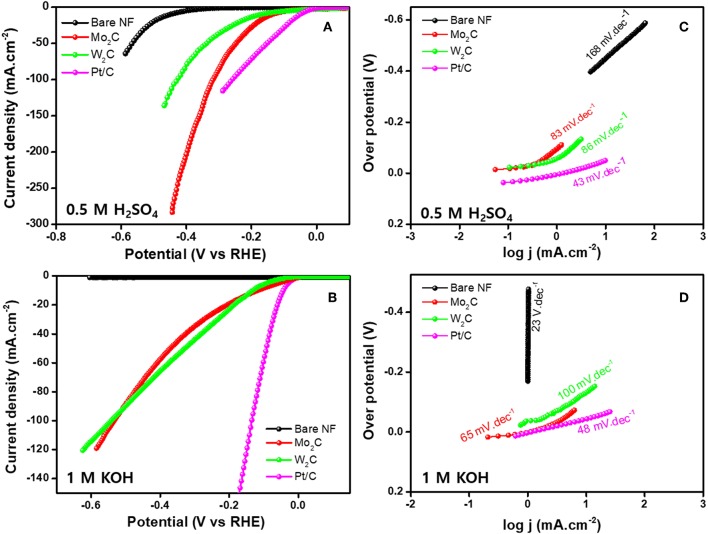
HER performance of bare NF, Pt/C, Mo2C, and W2C nanoparticle-decorated NF. (A,C) LSV profiles and their Tafel plots in 0.5 M H2SO4 and (B,D) LSV profiles and their Tafel plots in 1.0 M KOH.